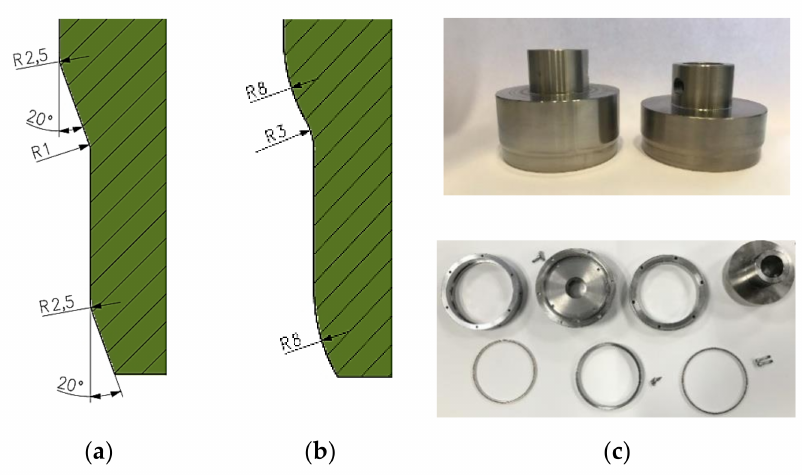
Figure 10. Sample Container detail in the sealing areas: ( a ) conical shape, ( b ) toroidal shape ( c ) manufactured